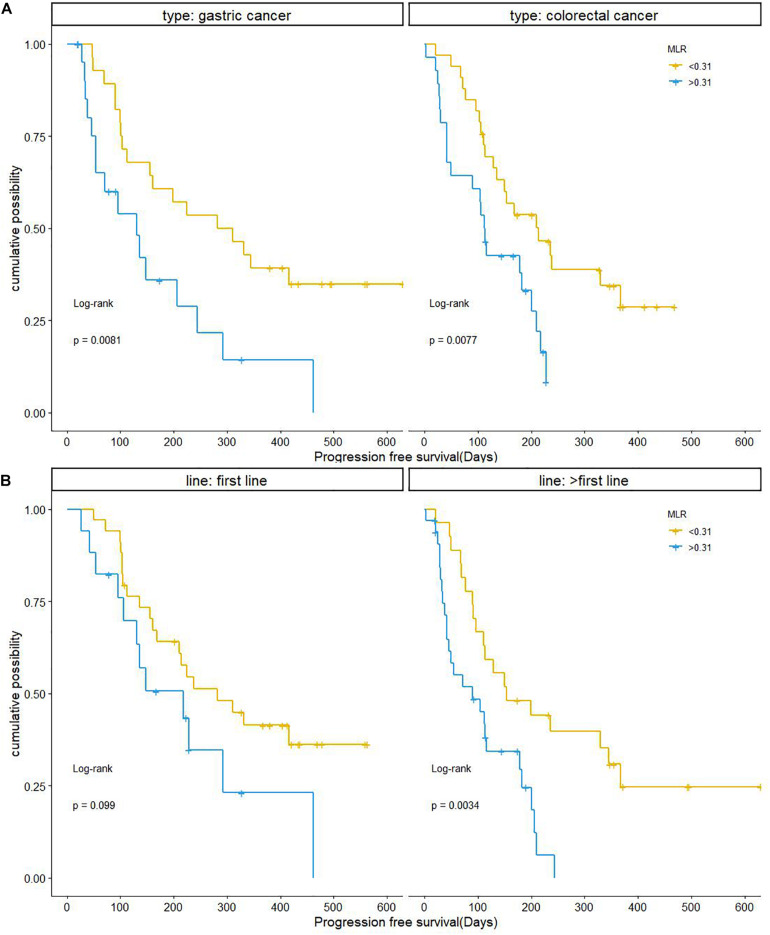
Kaplan–Meier curves of progression-free survival in relation to baseline MLR according to cancer type and number of treatment lines. (A) GC and CRC. (B) Number of treatment lines. CRC, colorectal cancer; GC, gastric cancer; MLR, monocyte-to-lymphocyte ratio.